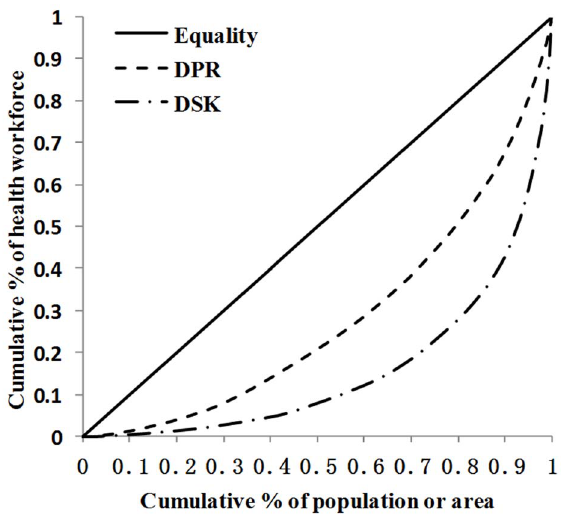
Fig. 3. Lorenz curve of the distribution of doctors per 10000 population ratio and per square kilometer in Chinese CHS. DPR: doctors per 10000 population ratio, DSK: doctor per square kilometer. All CHS centers (n 5 190) are represented in each